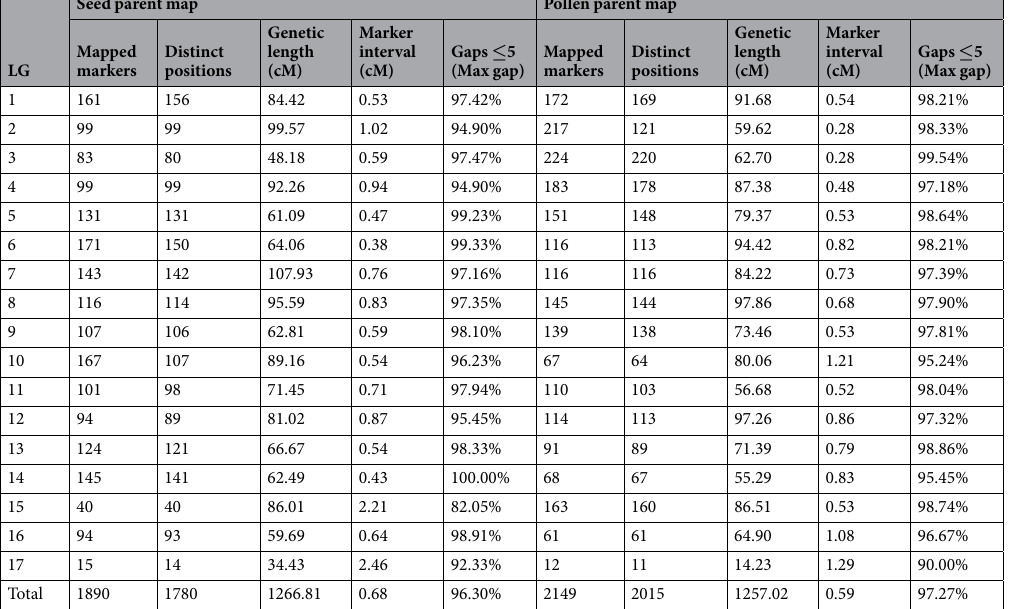
Table 3. Summary of sex-specific linkage maps of